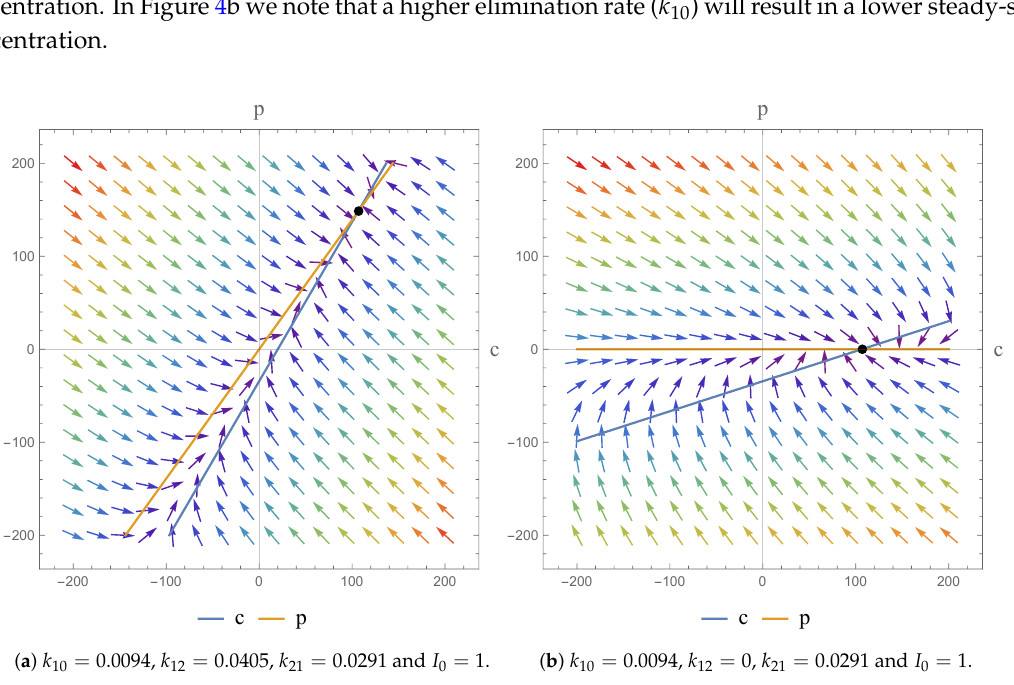
Figure 3. Phase portrait representing c ( t ) and p ( t ) . The arrows illustrates the trajectories of the system.